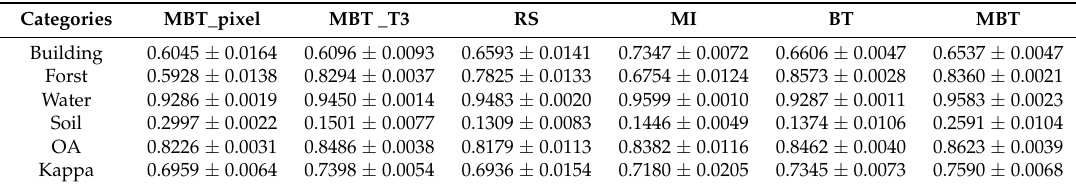
Table 6. Classification results for the RadarSat-2 imagery with different strategies.